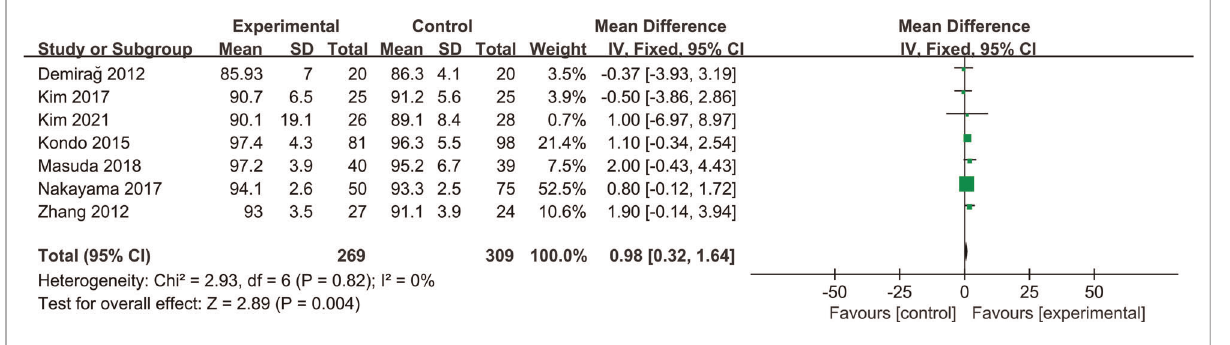
FIGURE 4 Forest pot for Lysholm score.